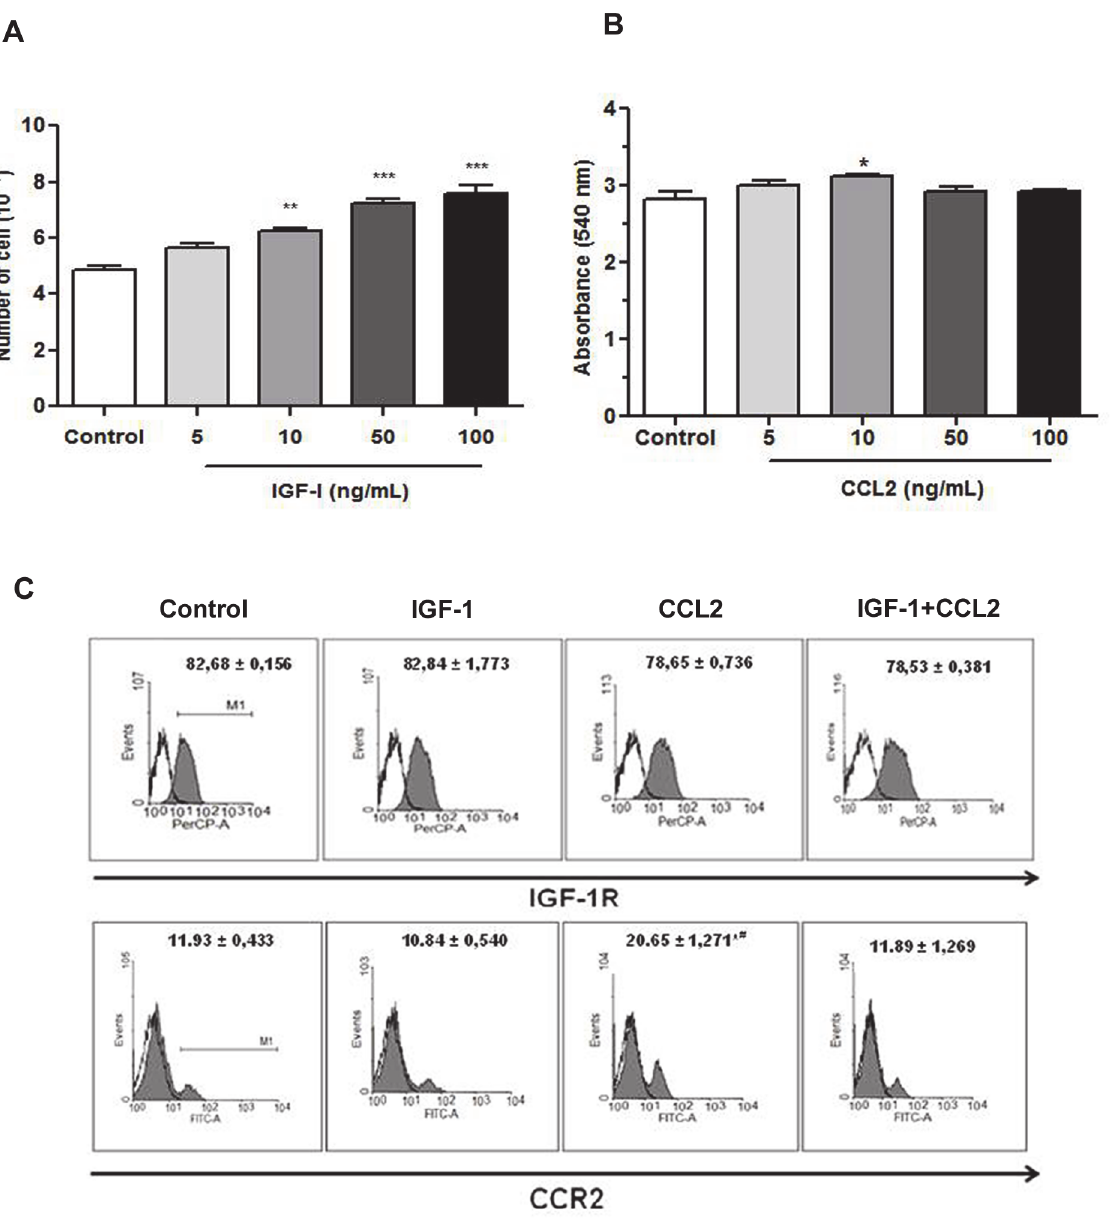
Fig 1. IGF-1 or CCL2 stimulated endothelial cell viability. tEnd.1 cells were treated with IGF-1 (A) or CCL2 (B) at concentrations of 5, 10, 50, or 100 ng/mL, and cell viability was determined by cell counting using a hemocytometer or MTT assay, respectively. (C) Flow cytometry results are presented as histograms of the average percentage of cells that expressed IGF-1R and CCR2 receptors (gray) and immunoglobulin control. Values and bars are represented as the mean ± SEM (n = 4/group). Results were analyzed by one-way ANOVA followed by Bonferroni ’ s post-test. Significant values compared to the control group: p < 0.05 ( * ) or p < 0.0001( *** ); significant value compared to control group and the other treatments: p < 0.0001